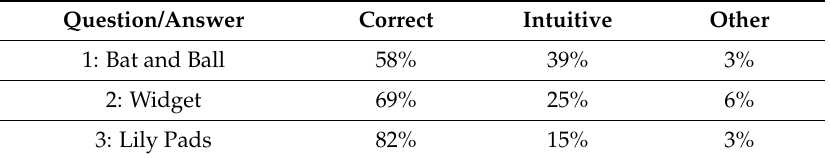
Table A7. Distribution of Answers on the CRT for Both Men and Women.